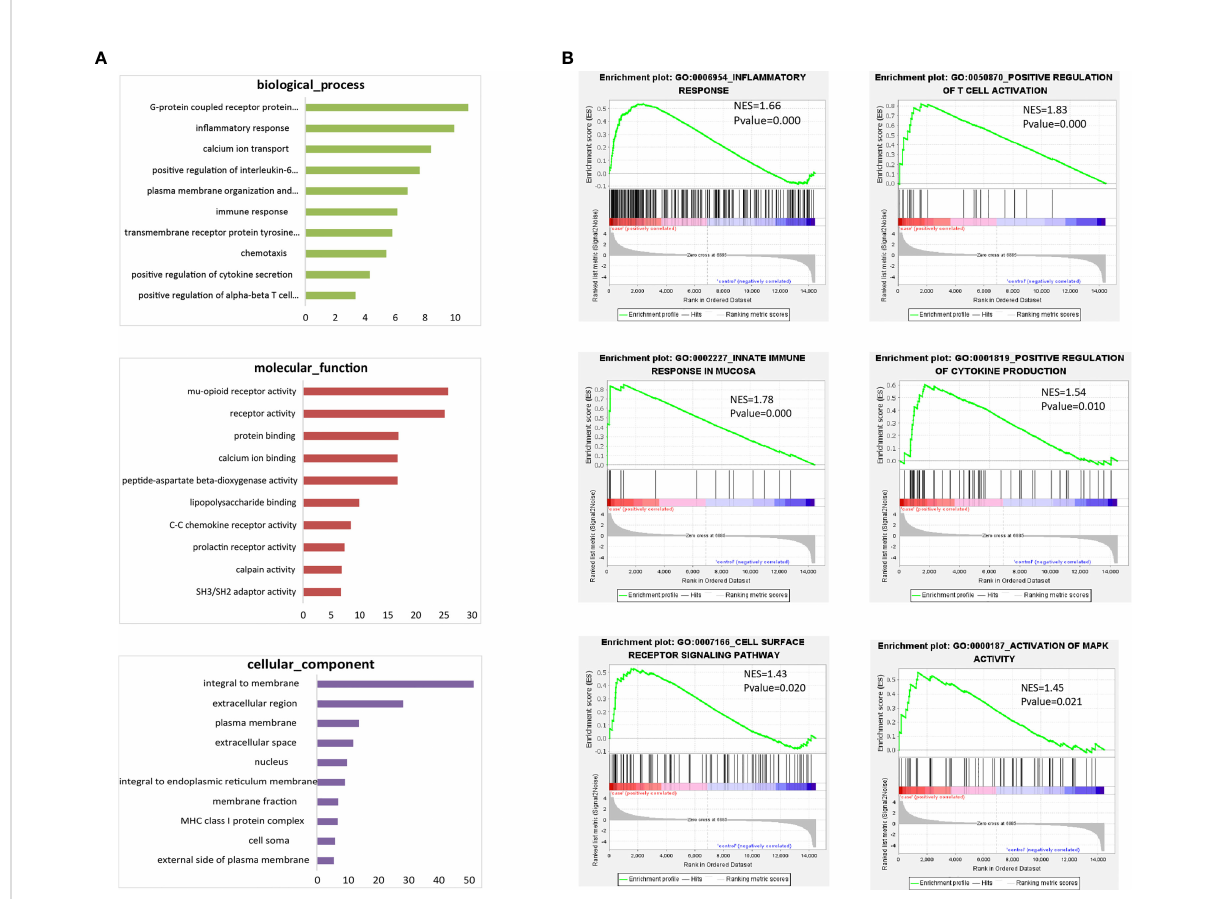
FIGURE 6 Microarray analysis for CD19 + ICOSL + /CD19 + ICOSL - B-cell subset. (A) GO enrichment analysis for DE mRNAs of CD19 + ICOSL + B cells. (B) GSEA for the potential function of DE mRNAs of CD19 + ICOSL + B